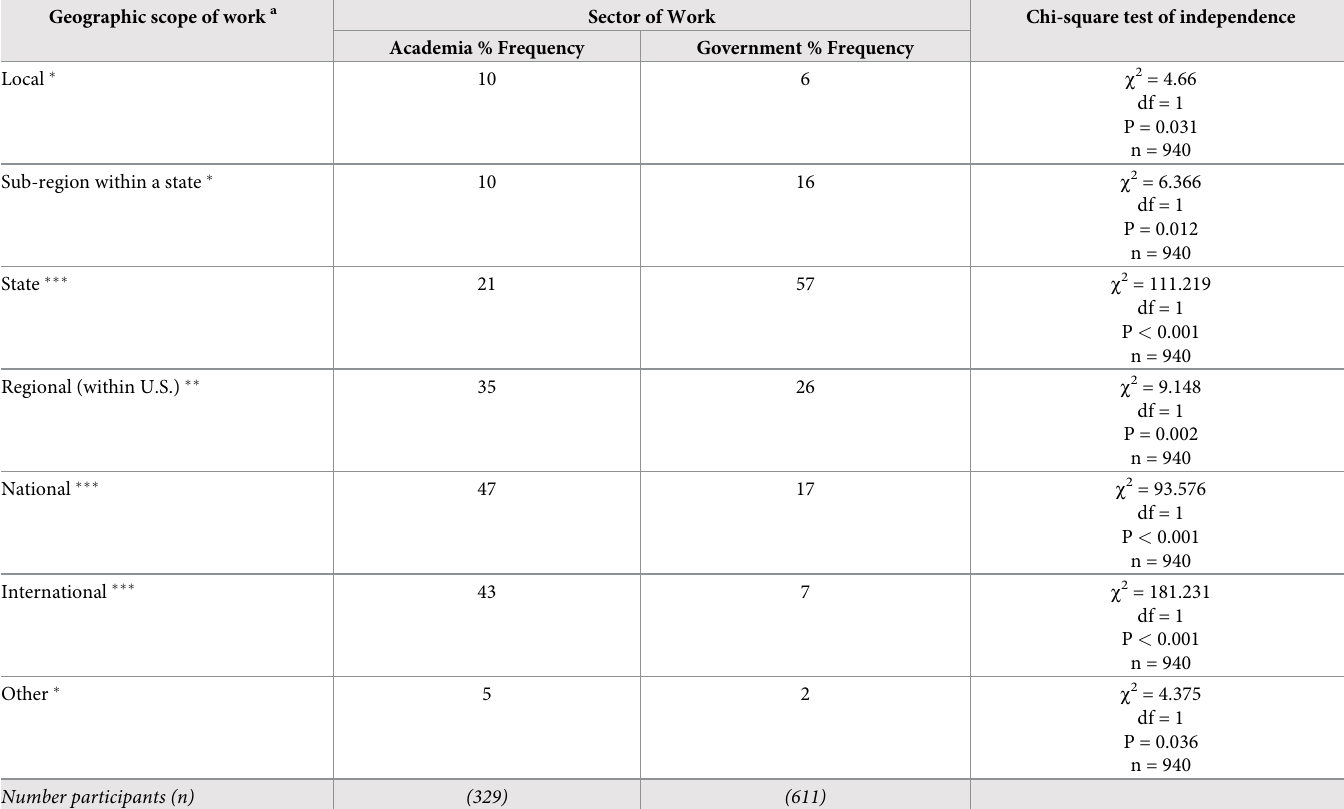
Table 4. Geographic scope of work of